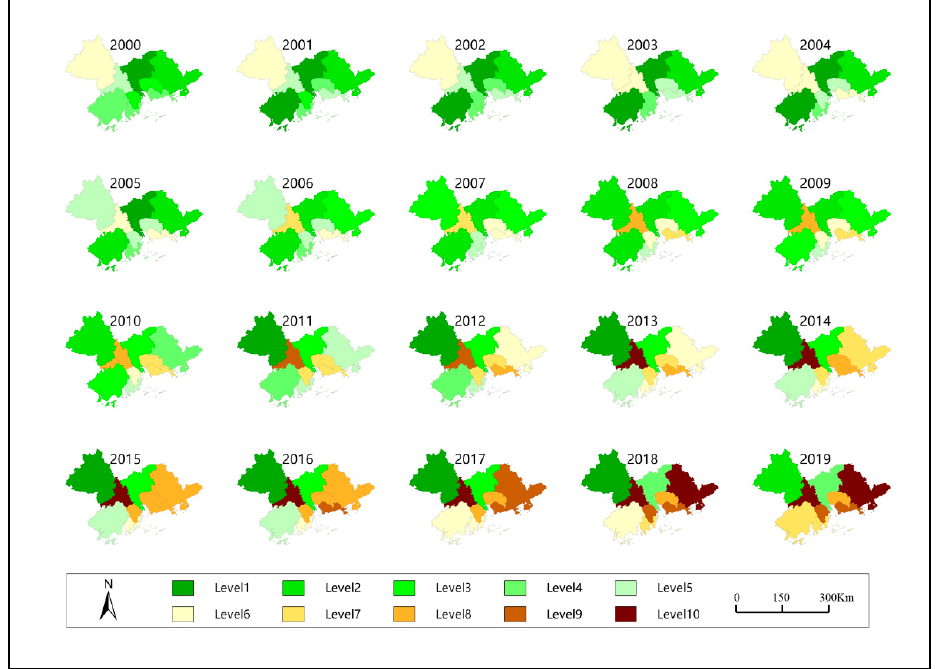
Figure 4. Level of the GTWR coefficient of service economy on the development of manufacturing in different years. different